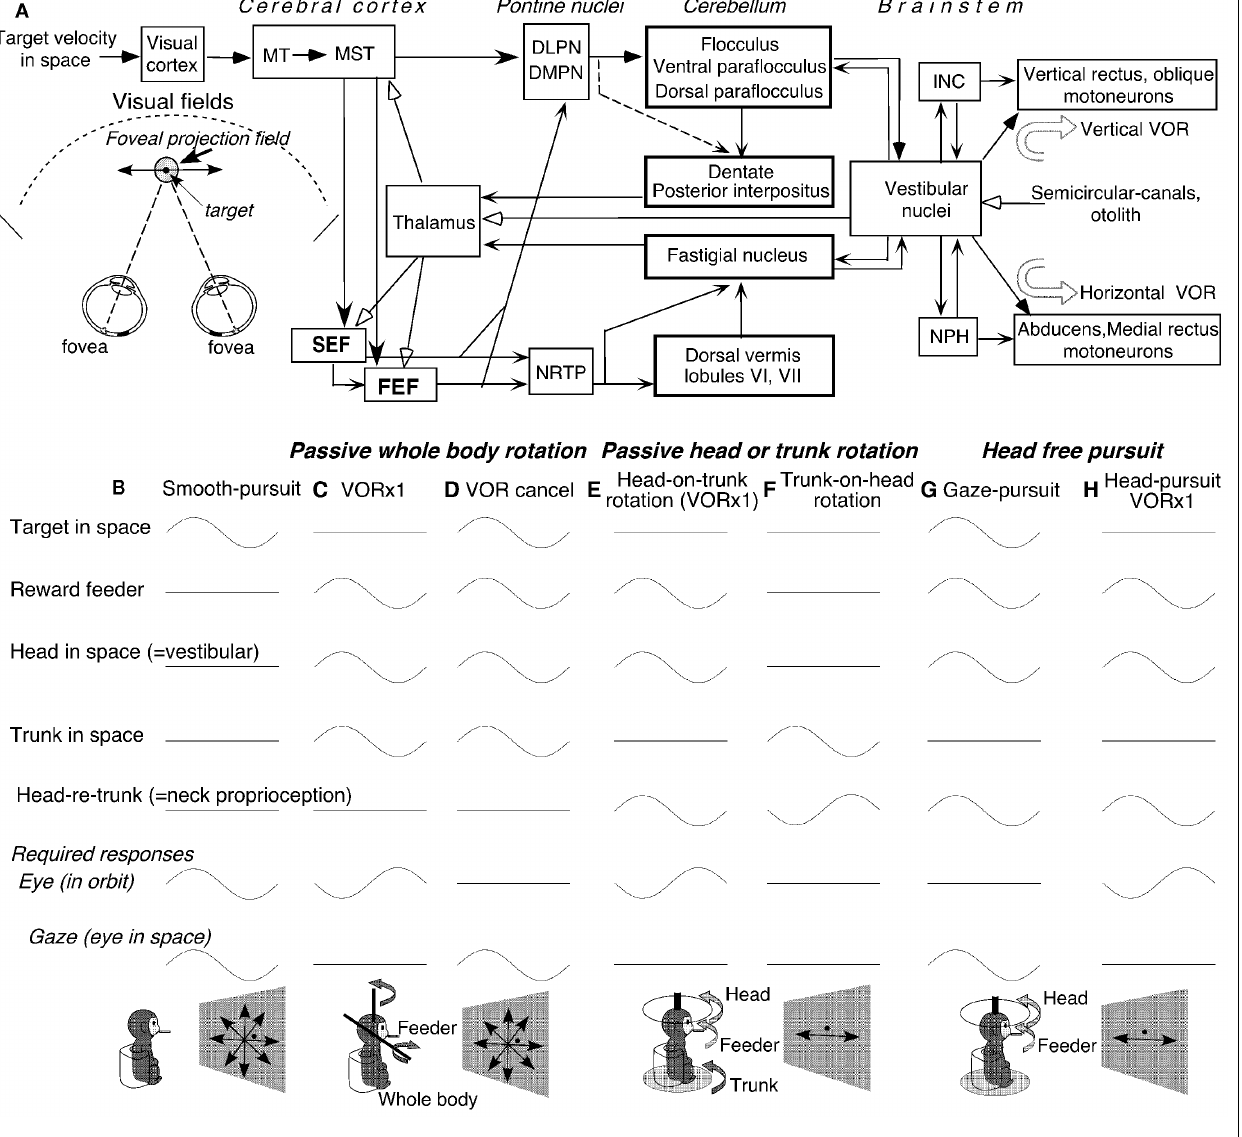
FIGURE 1 | Major pathways related to smooth-pursuit eye movements and behavioral tasks. (A) A schematic top view of visual fields and foveal projection field in three dimensional space, major pathways related to smooth-pursuit eye movements and vestibular inputs. (B–H) Behavioral tasks. Only sinusoidal stimulus condition is shown for simplicity. DLPN, dorsolateral pontine nucleus; DMPN, dorsomedial pontine